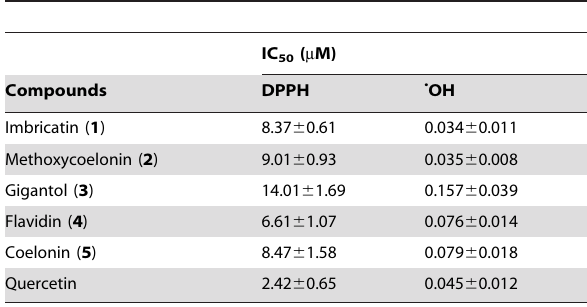
Table 1. Radical scavenging activities of stilbenoids 1–5 on DDPH and N OH